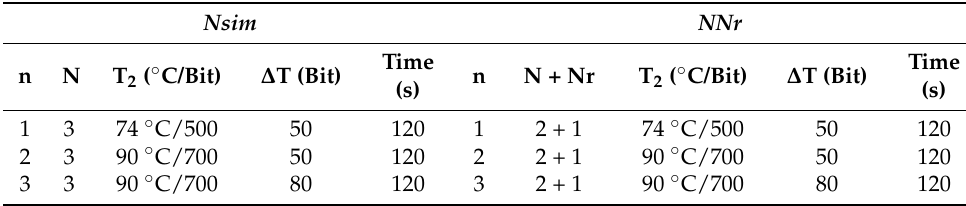
Figure 9. Processed MATLAB data example. Over 50 measurements with different parameters were made, and the measurement results for three significant different operating points for both Nsim and NNr algorithms are presented in the paper (Table 4). Table 4. Chosen measurement parameters for both